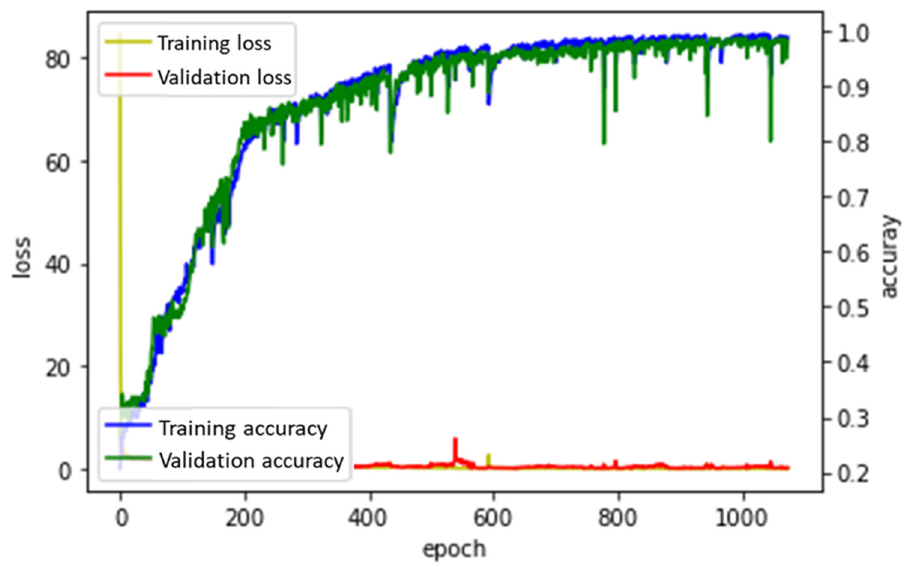
Figure 11. Performance graph by Adam optimizer.